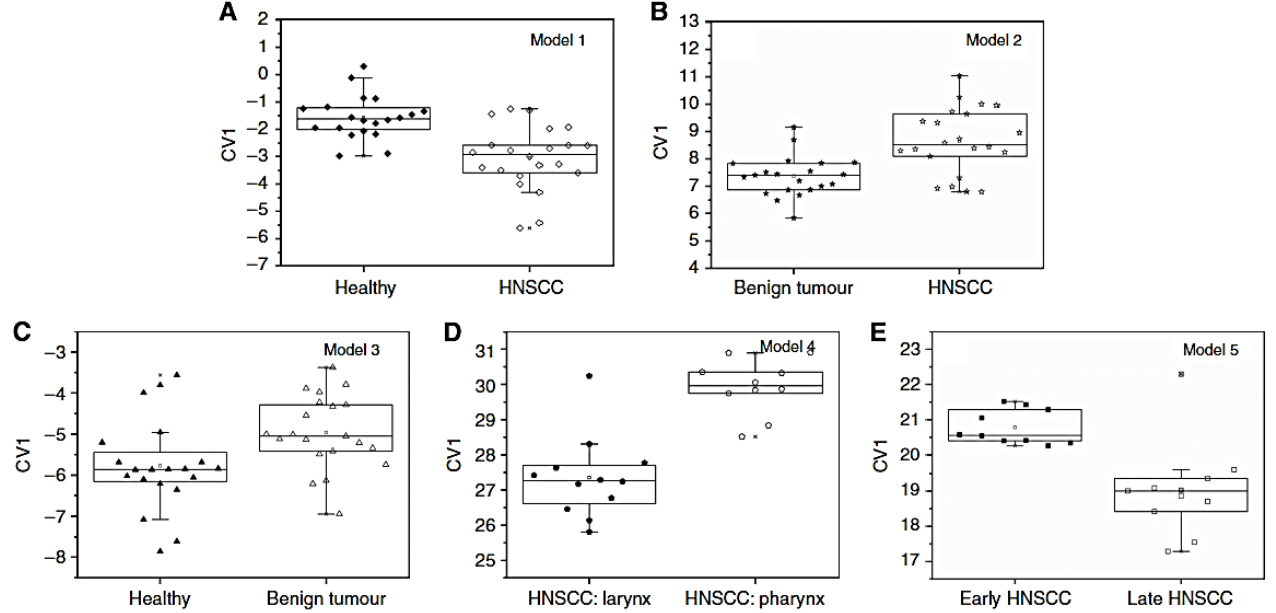
Figure 12. Predictive DFA models for distinguishing: ( A ) HNSCC patients from healthy (tumour- free) subjects, ( B ) HNSCC from benign tumour patients, ( C ) benign tumour patients from healthy subjects, ( D ) larynx malignancy from pharynx malignancy and ( E ) early HNSCC from late HNSCC. Reproduced with permission from [57].